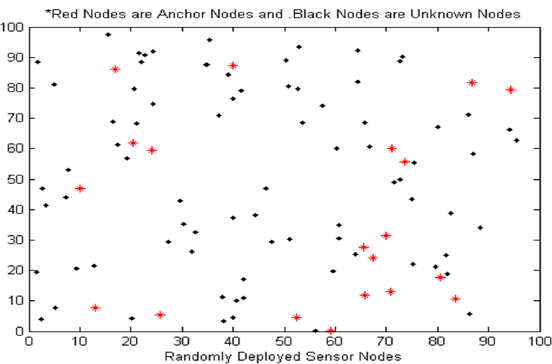
Figure 6. Node distribution diagram.